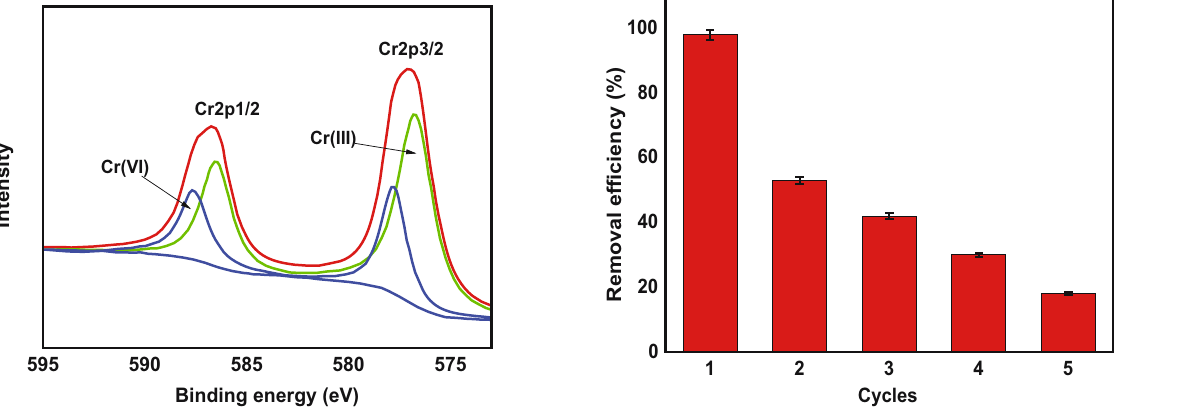
Figure 8: Reusability of PDA/NC nanocomposite for the removal of Cr ( VI ) ions up to fi ve